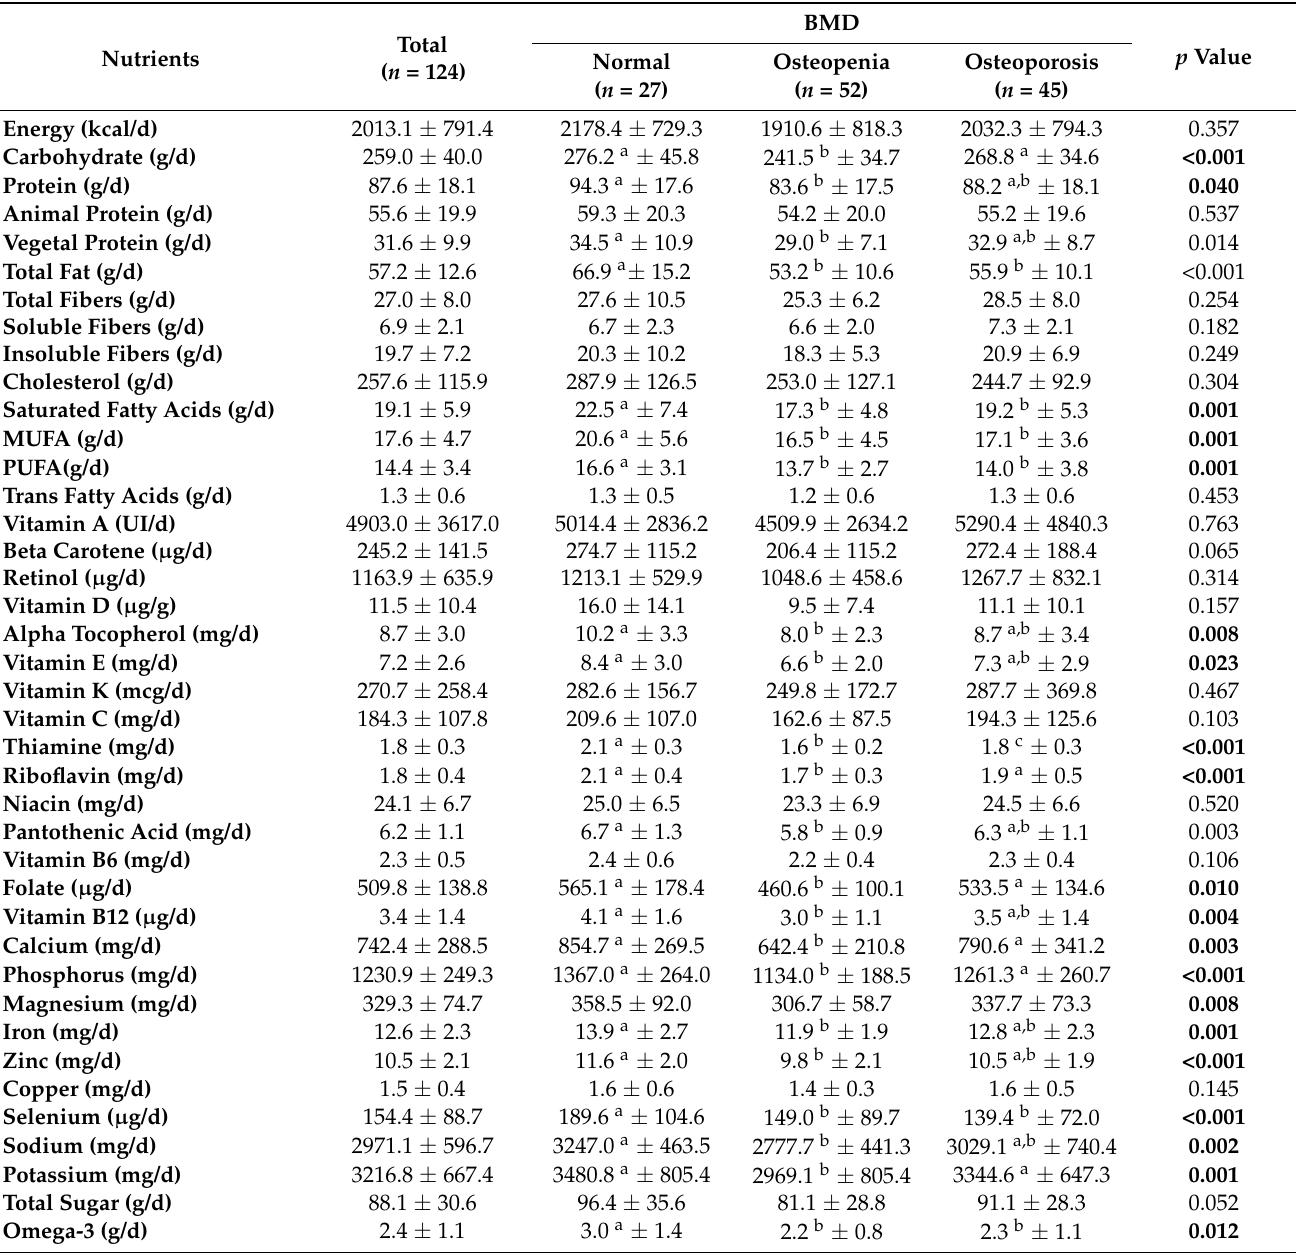
Table 2. Mean and standard deviation of energy and nutrient intake according to bone mineral density categories in postmenopausal